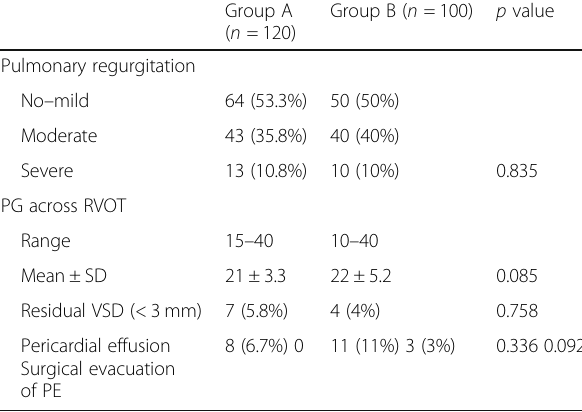
Table 4 Pre-discharge echocardiographic